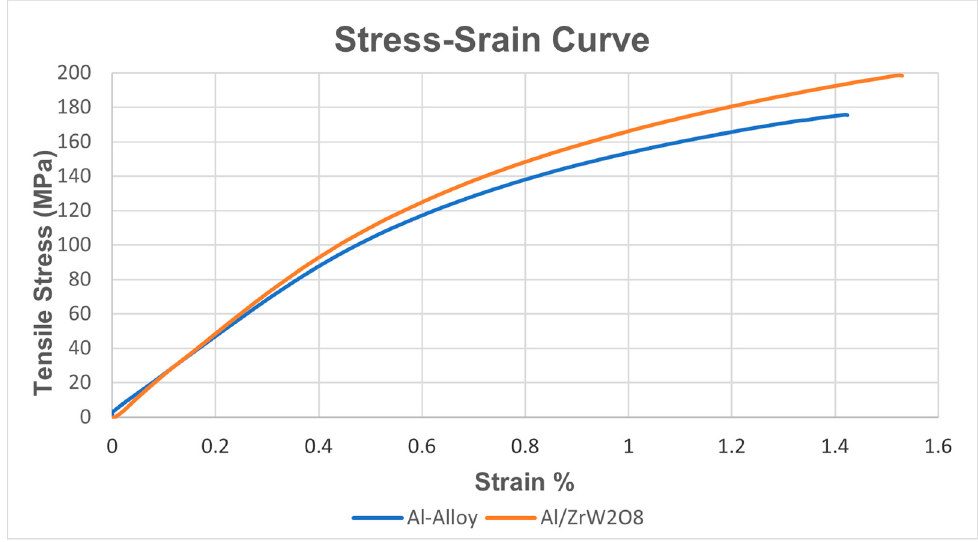
Figure 10. Effect of ceramic on tensile strength of base aluminum alloy and composite.